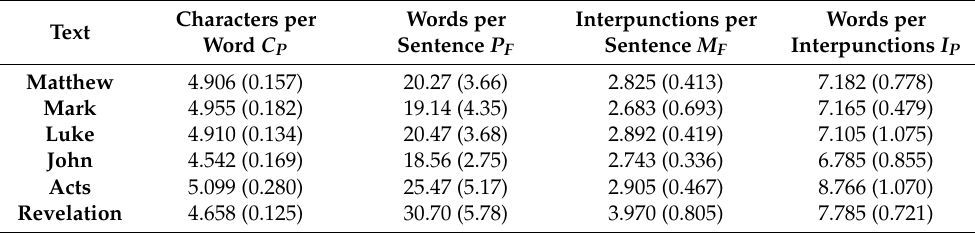
Table 4. Full Texts. Average number of characters per word C P , words per sentence P F , interpunctions per sentence (also, number of word intervals) M F , words per interpunctions (word interval) I P . The number between parentheses gives the standard deviation for text blocks of 500